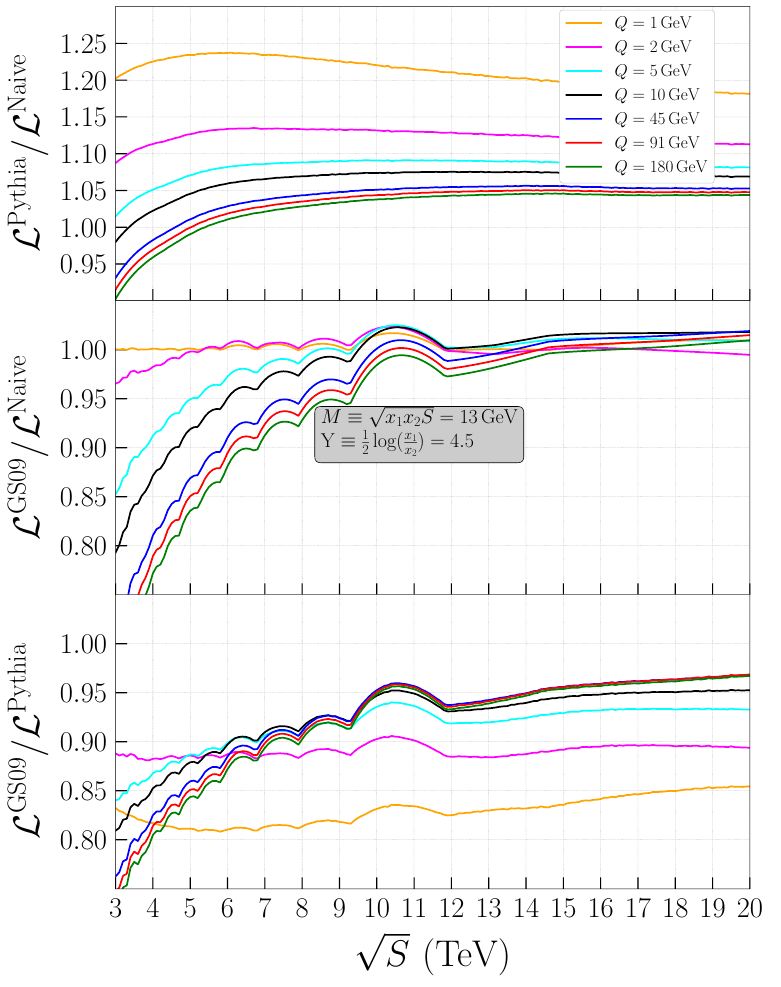
Figure 10 . Ratios of the DPS luminosities at different values of factorization scale Q as functions √ of collision energy S for the u - ¯ u flavour